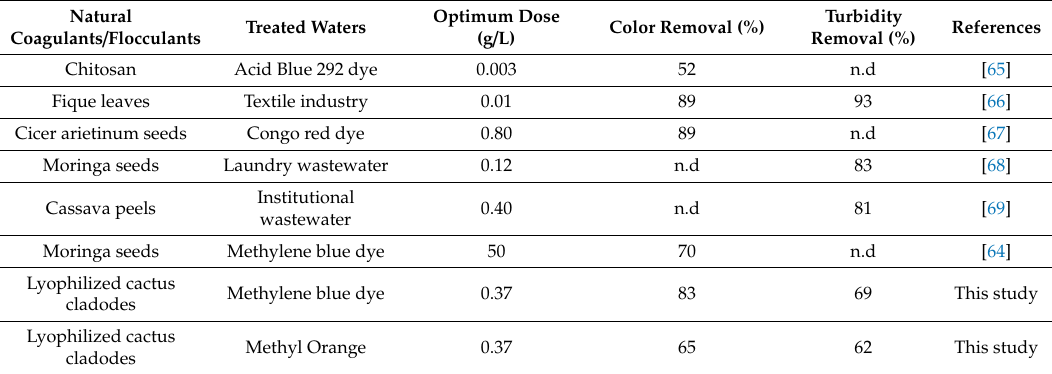
Table 6. Flocculating ability of various